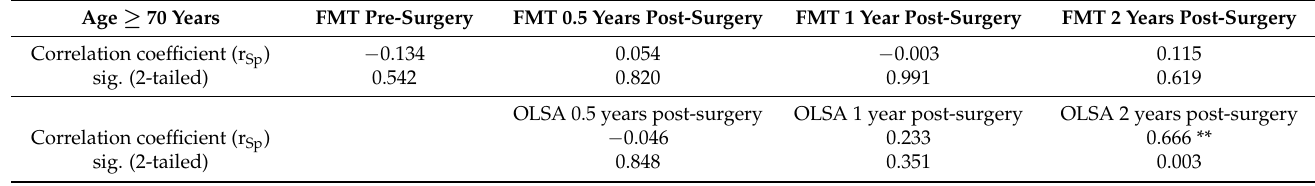
Table 5. Correlation analysis for speech perception and age in the elderly group.